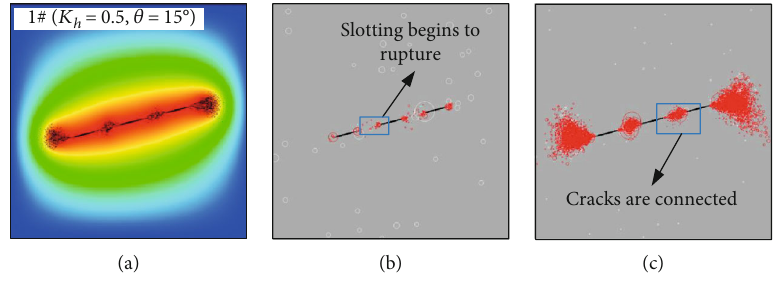
Figure 11: Acoustic emission events of model #1 during